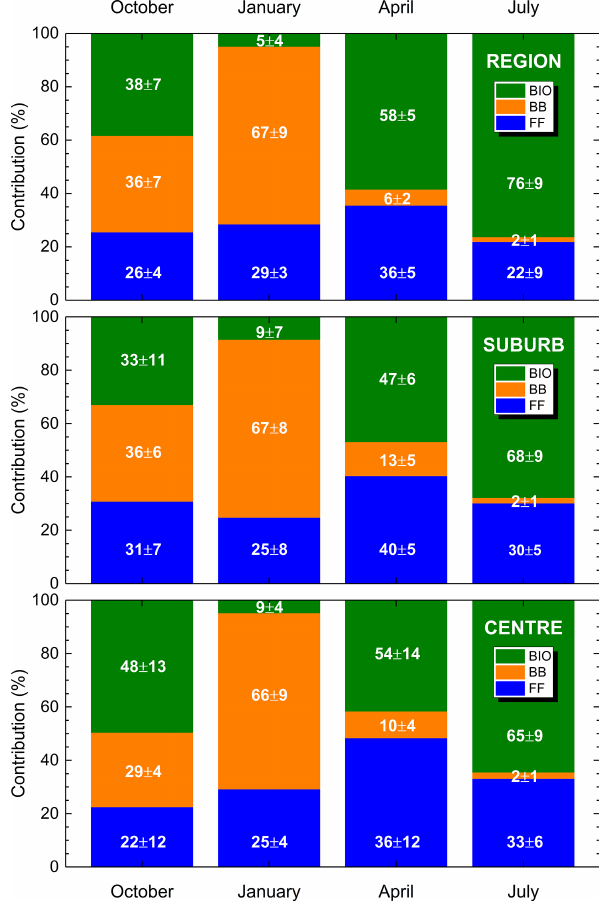
Figure 7. Distribution of mean contributions from FF combustion, BB and biogenic sources (BIO) with SDs to the PM 2 . 5 -fraction OC for regional background in the Carpathian Basin, suburban area and city centre of Budapest for different months representing different seasons. The corresponding median atmospheric concentrations of OC are given in Table